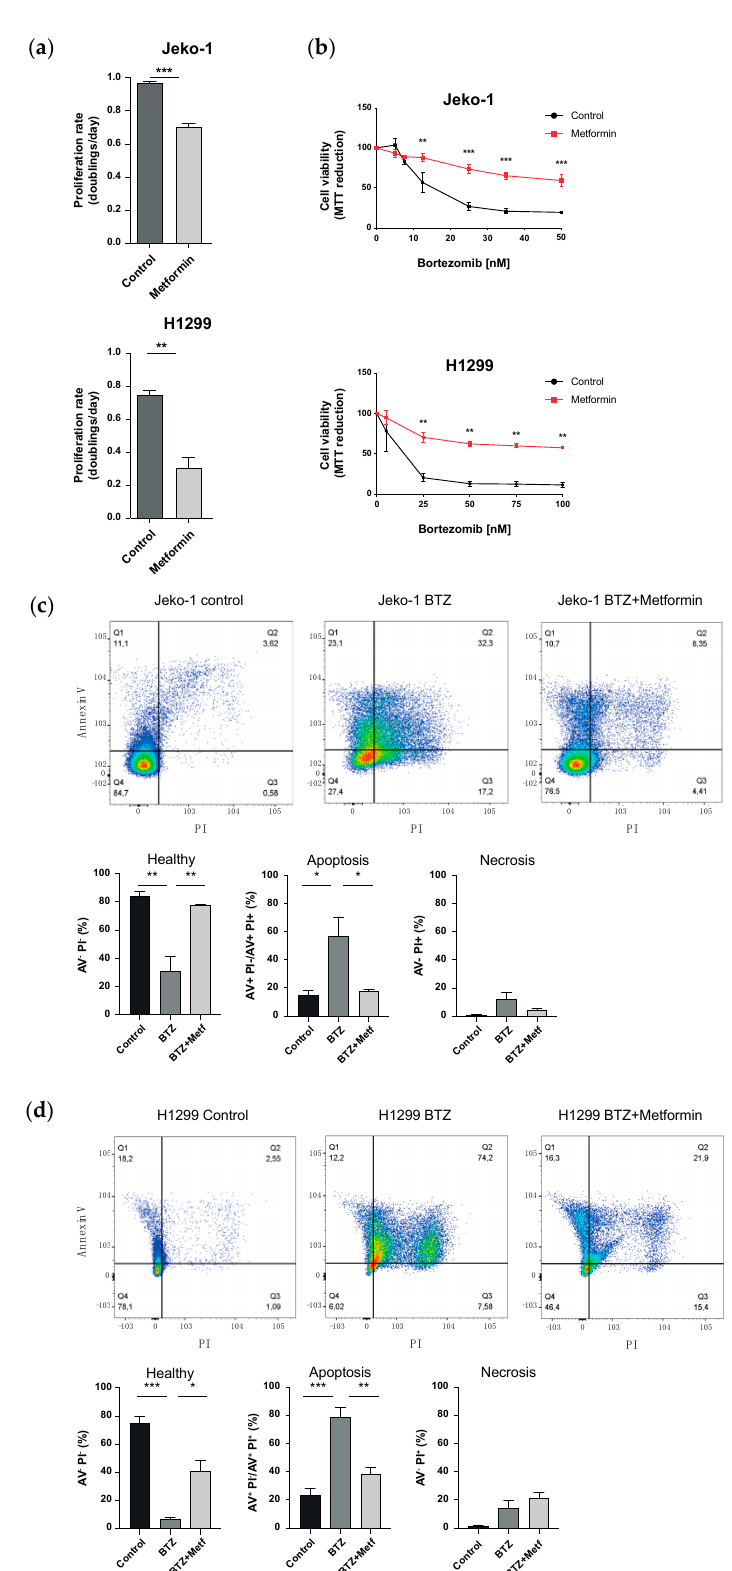
Figure 1. Metformin reduces cancer cell proliferation but increases resistance toward proteasome inhibition. ( a ) Proliferation rates of Jeko-1 and H1299 cells treated with 10 mM metformin for 72 h. Proliferation rates were determined as described in the methods section. Bar graphs show mean + SEM ( n = 3 independent experiments per cell line). Significance was determined using Student’s paired t